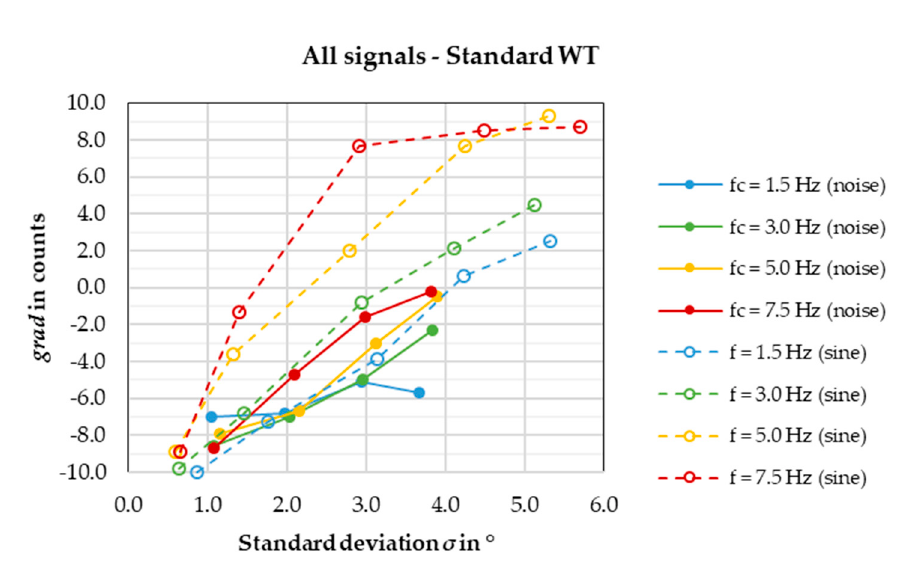
Figure 8. Pressure gradients in the empty test section for all measured signals, in the standard wind tunnel configuration, in one diagram.